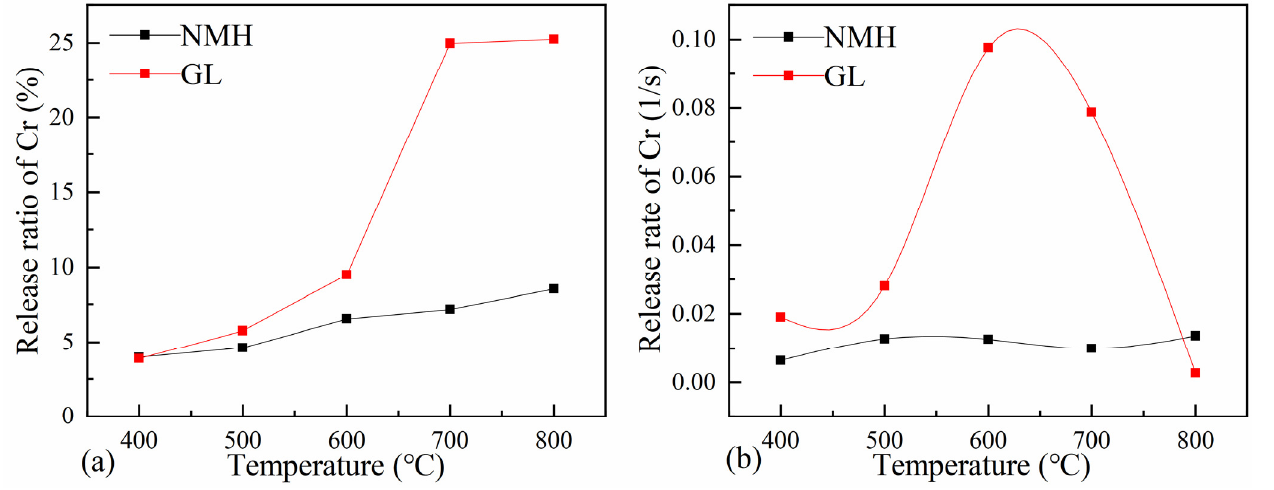
Figure 6. The release behavior ( a ) and reaction rate ( b ) of Cr at different final temperatures during pyrolysis.